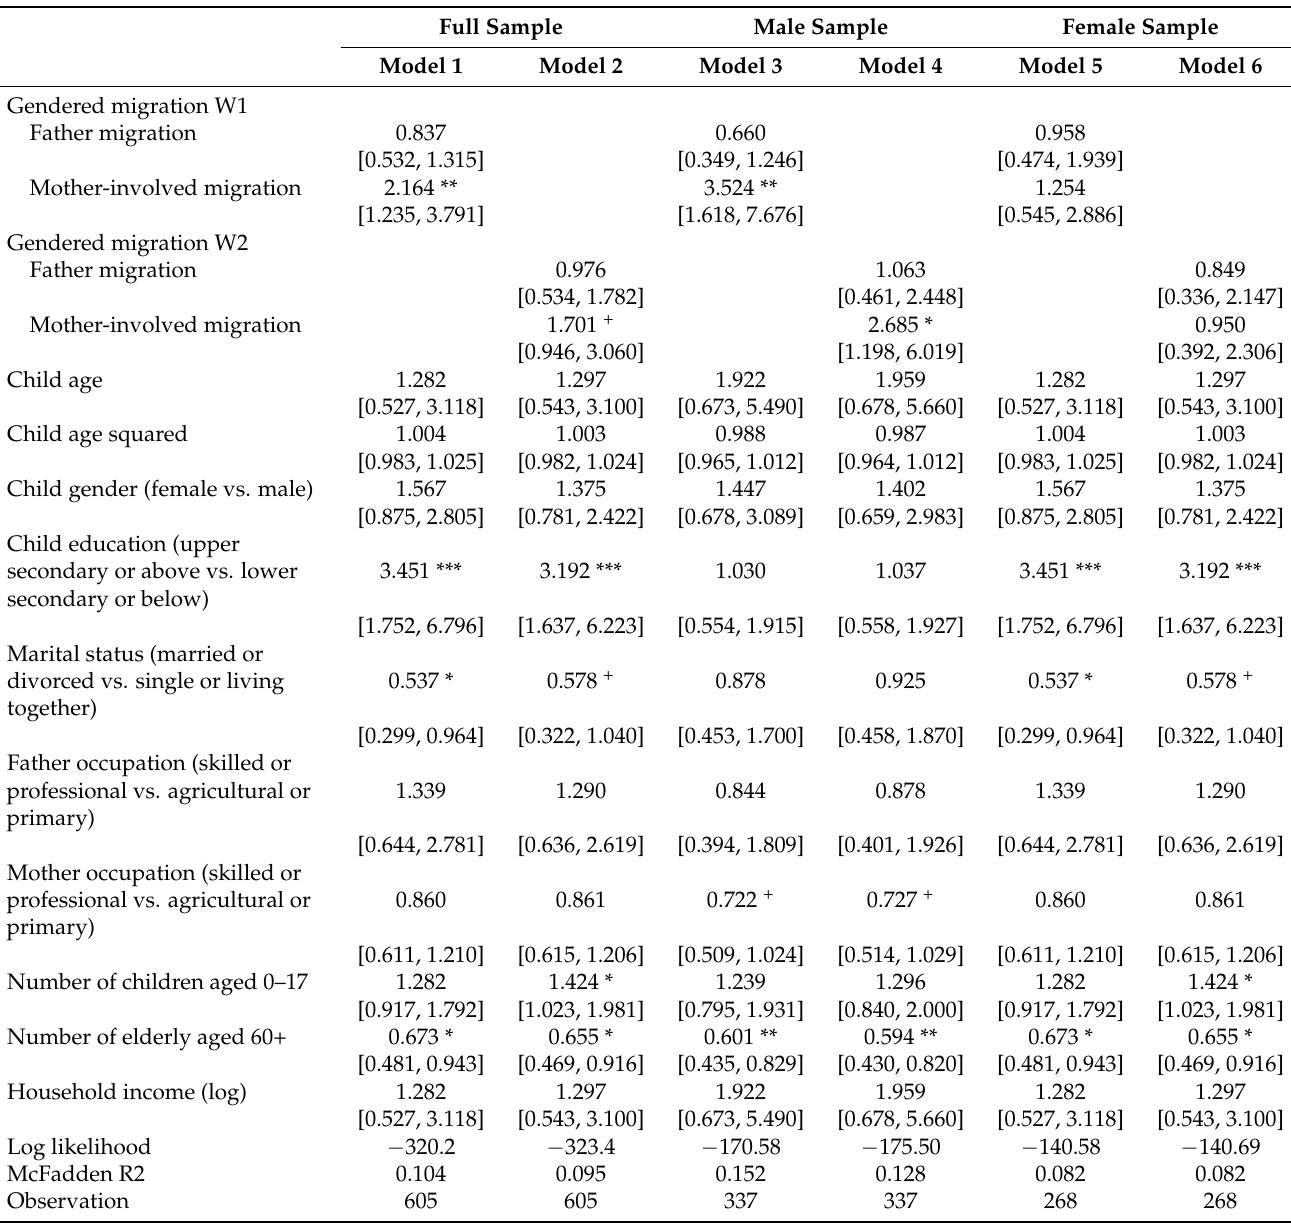
Table 4. Effects of gendered migration on youth labor